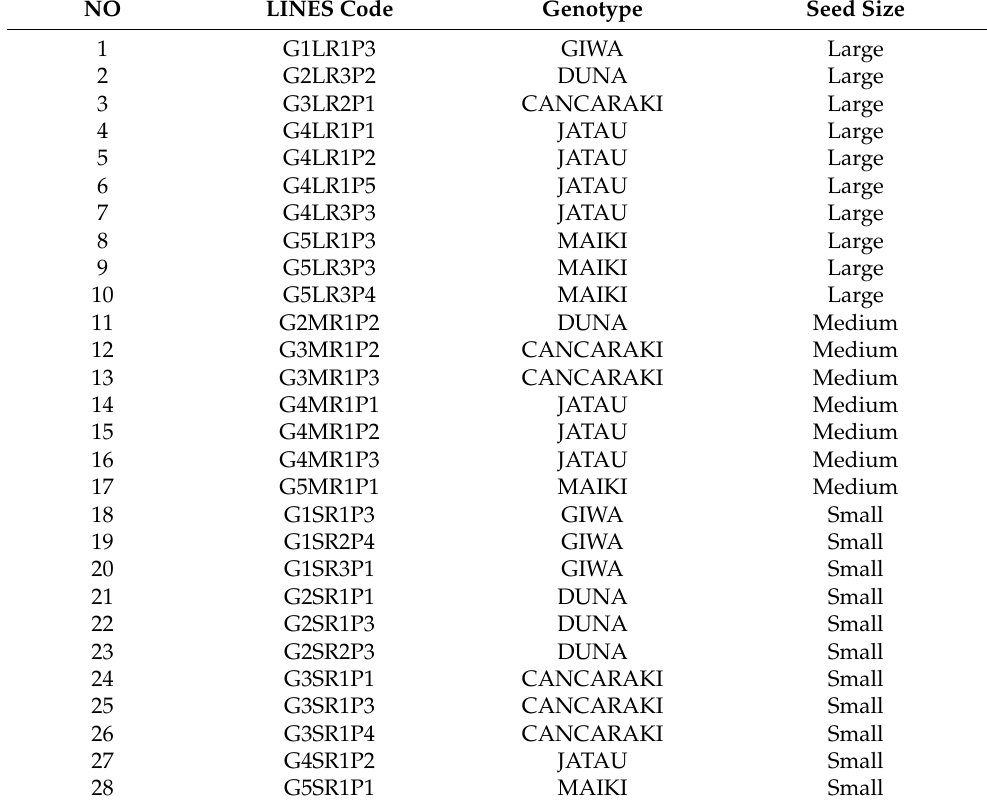
Table 1. Twenty-eight Bambara groundnut